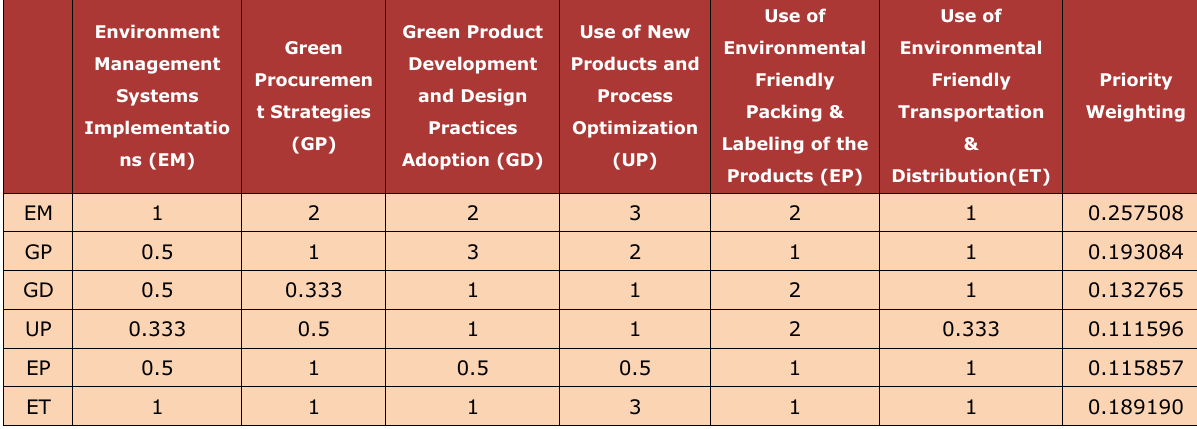
Table 5.1. Strategies of Innovative green practices